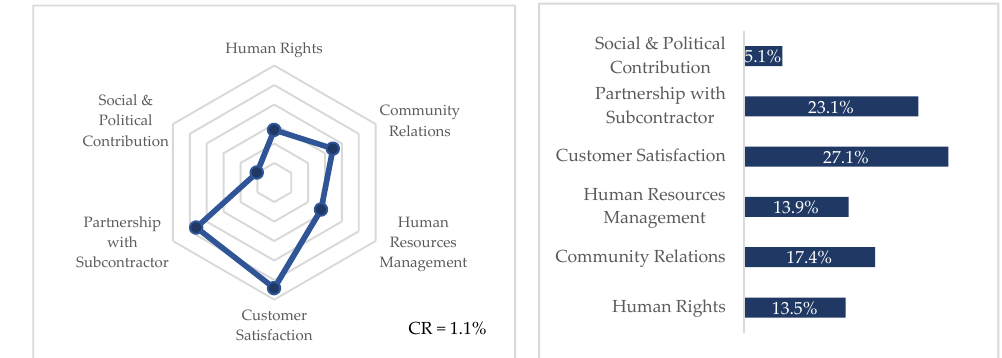
Figure 5. Local weights for S, social factors.